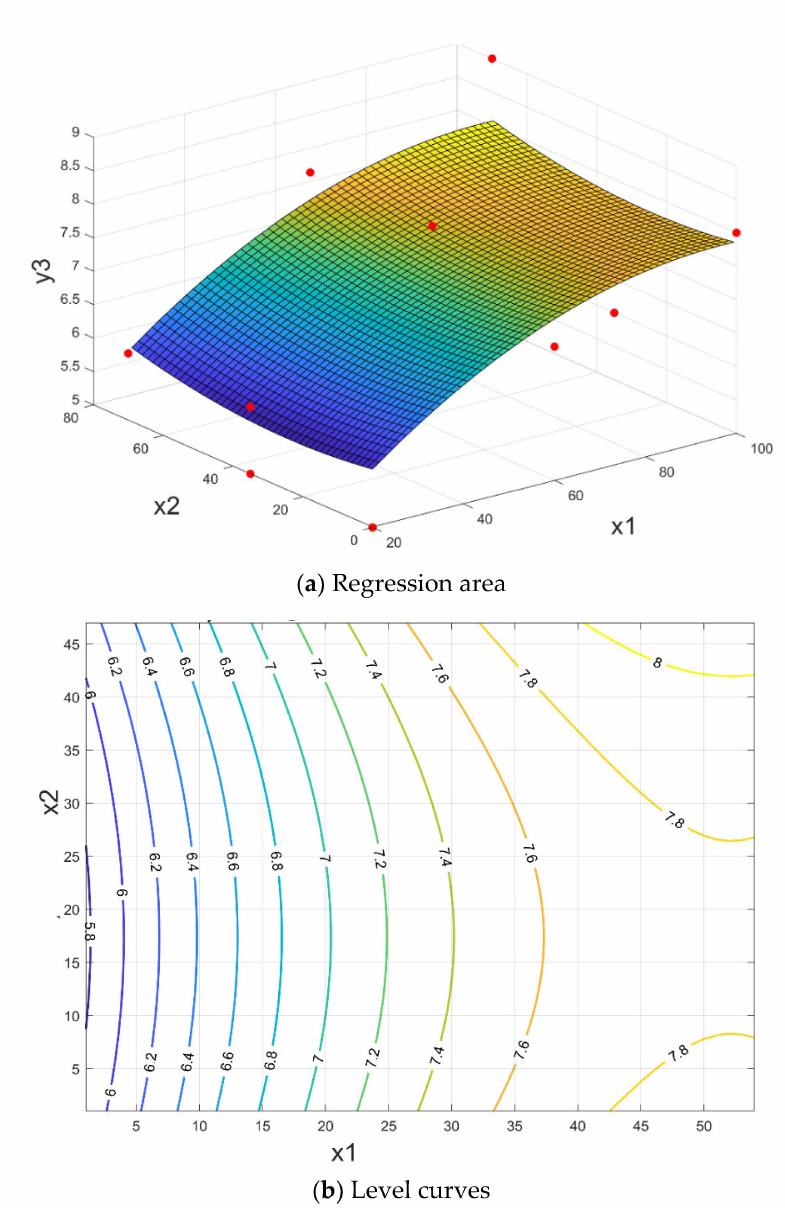
Figure 15. The briquettes crush range depending on the proportion of ferrous sludge and sludge mill scale, for a medium value of sintering sludge y 3 = f (x 1, x 2 , x 3 med